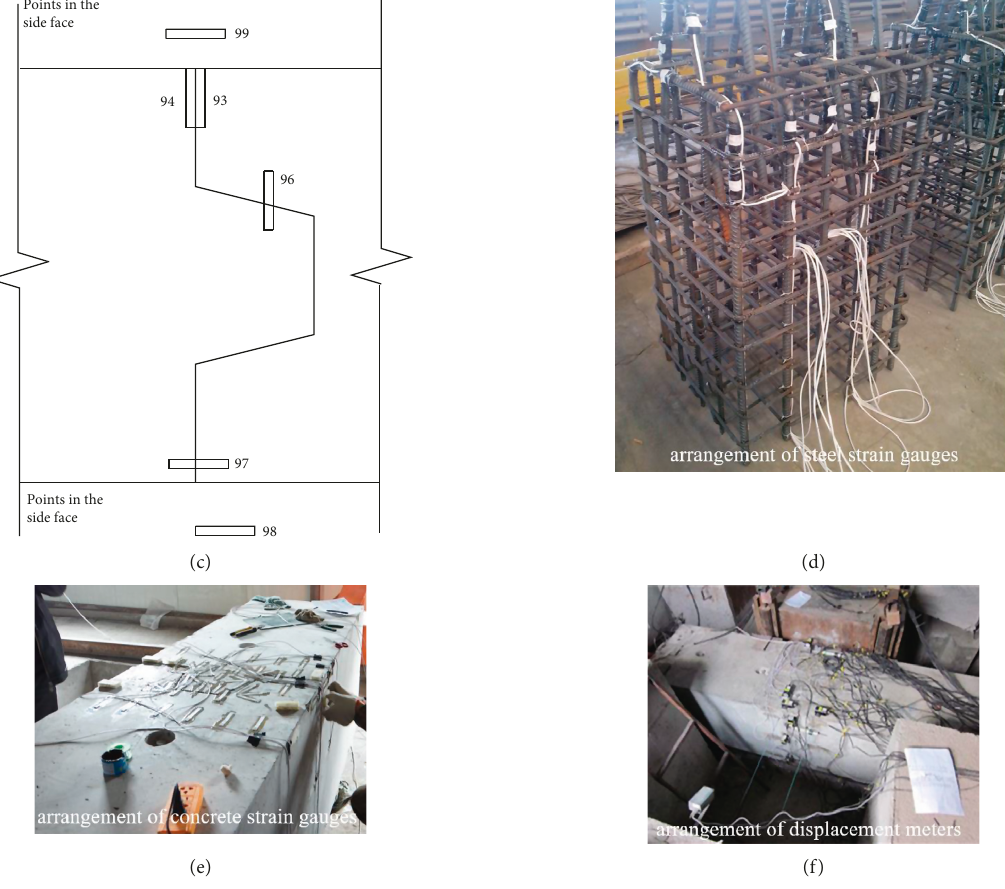
Figure 7: Test elements. (a) Steel strain gauges layout. (b) Concrete strain gauges layout. (c) Displacement meters layout. (d) Arrangement of steel strain gauges. (e) Arrangement of concrete strain gauges. (f) Arrangement of displacement